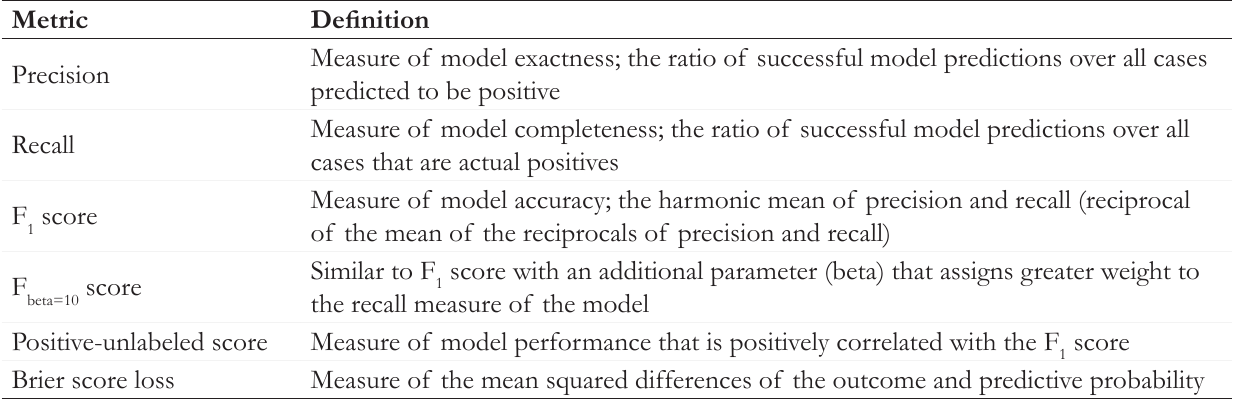
Table 2. Performance Metrics